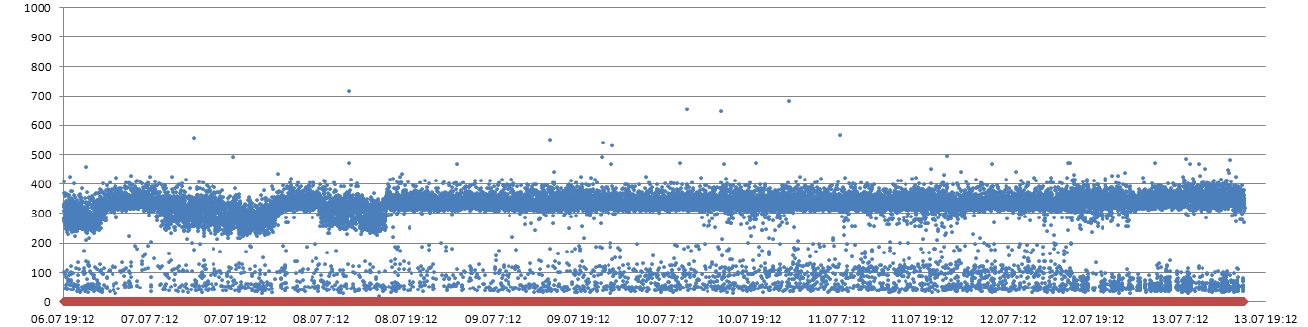
Fig. 6. RTT of LMT 4G cellular network operator subsystem, ms.